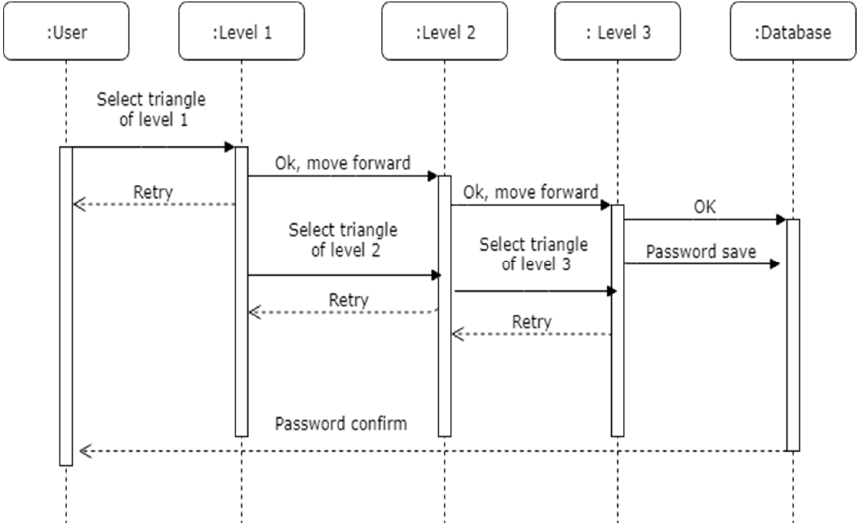
Figure 3 . Sequence diagram for password registration and verification. Table 2 . Notations.